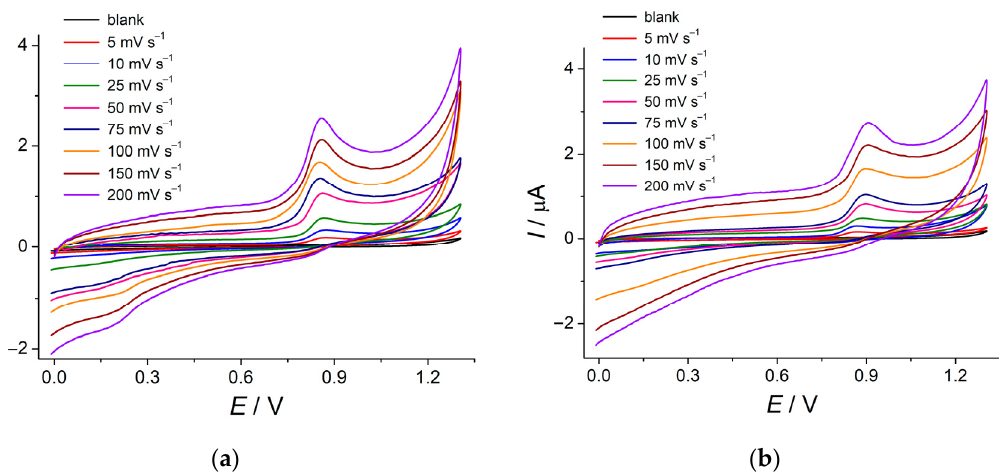
Figure 8. CVs of 25 µM isopropylmethylphenols at the polythymolphthalein/MWCNTs/GCE in Britton-Robinson buffer pH 2.0 at various potential scan rates: ( a ) thymol; ( b ) carvacrol. Electrooxidation of thymol and carvacrol is a diffusion-controlled process, as confirmed by the linear dependence of oxidation currents vs. the square root of the potential scan rate and the slope of ln I = f (ln υ ) close to 0.50 [64] (Equations (3) and (4) for thymol and Equations (5) and (6) for carvacrol).